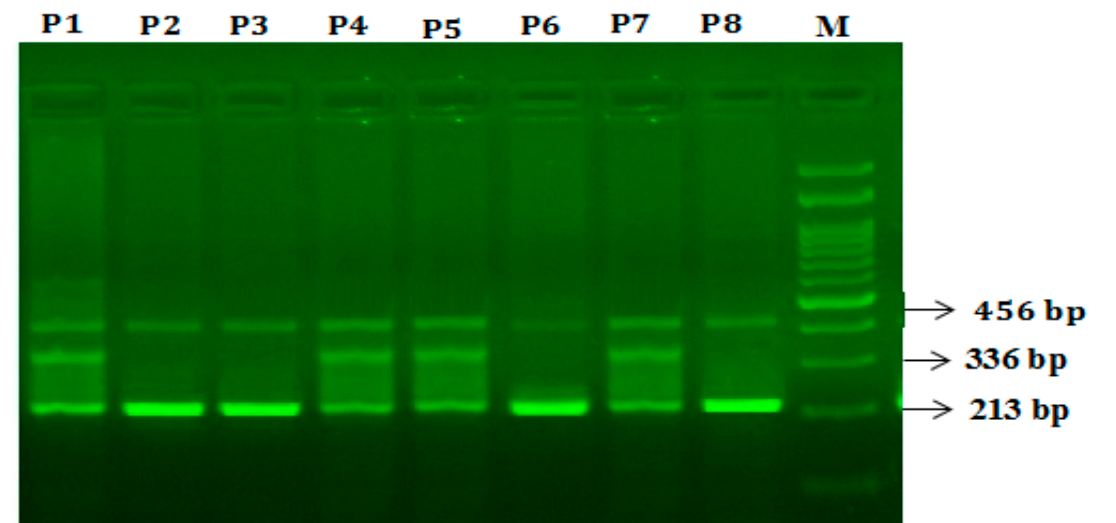
Figure 4. Detection of glyoxalase 1 genotyping GLOI rs1130534 T>A utilizing Refractory Mutation System PCR (ARMS-PCR) in T2DM patients. M-100 bp DNA ladder; Heterozygous A/T—in patients P1, P4, P5, P7; Homozygous T/T—in patients P2, P3, P6, P8.